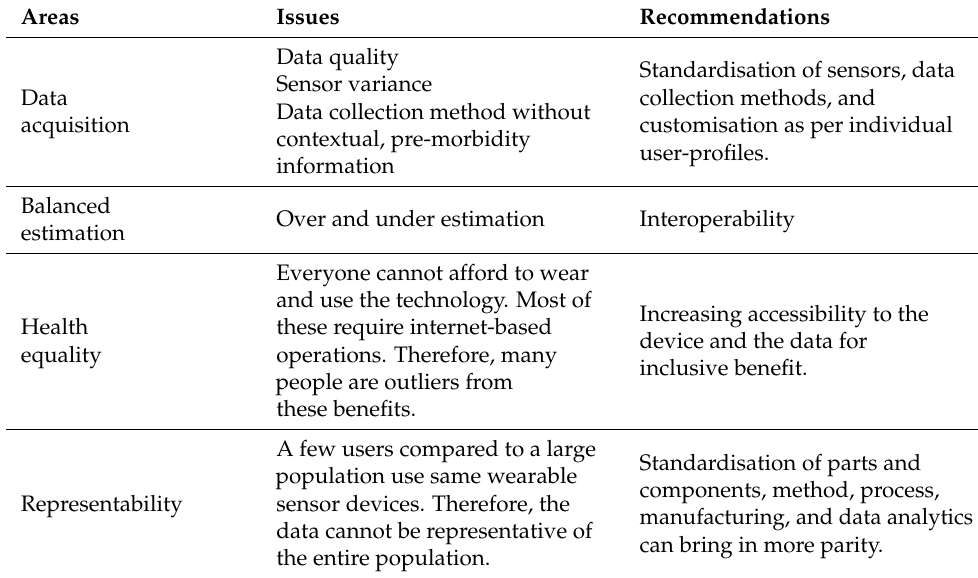
Table 5. Key issues with wearable healthcare